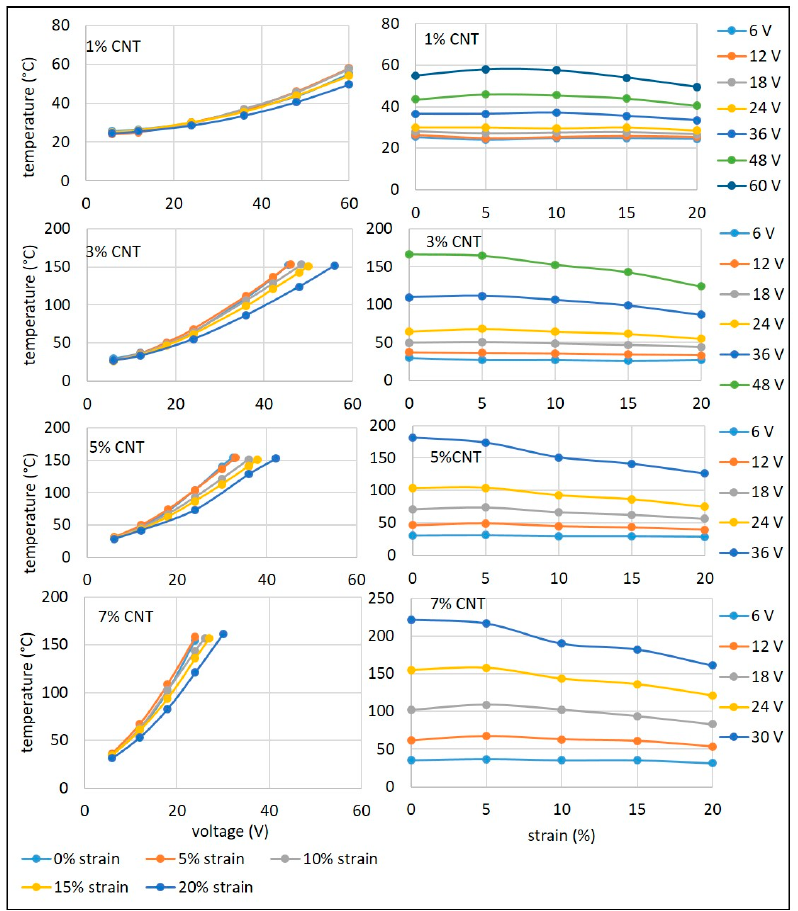
Figure 7. Increase in temperature with voltage ( left ) and with strain ( right ) at different CNT con- tents.